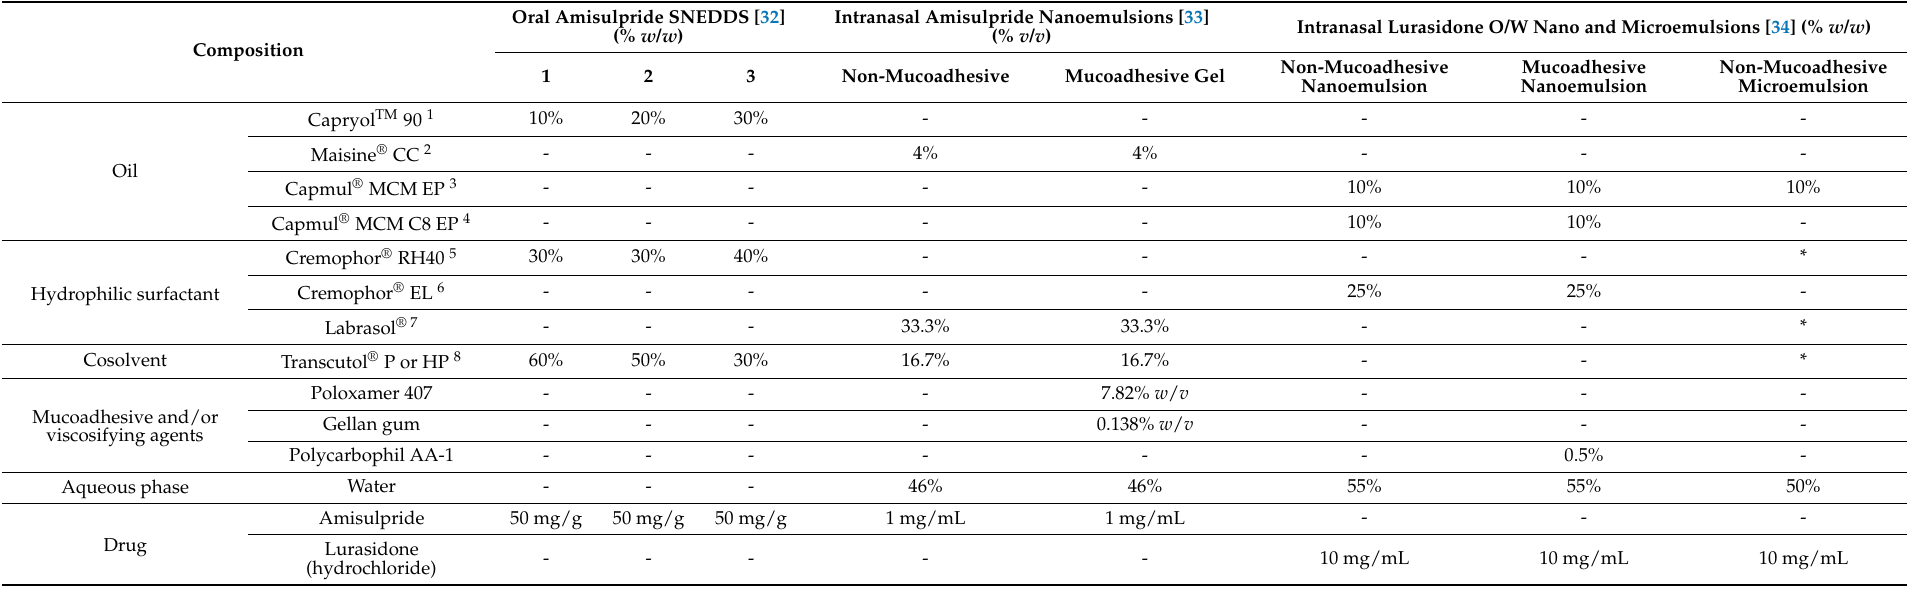
Table 7. Detailed composition of the amisulpride oral SNEDDS and intranasal nanoemulsions, and the lurasidone intranasal nano and microemulsions. Excipient and drug quantities and units are shown as reported in the respective articles ( w / w , w / v % or v / v for excipients, and mg/g or mg/mL for drugs). For the excipients the brand name was used (when available).